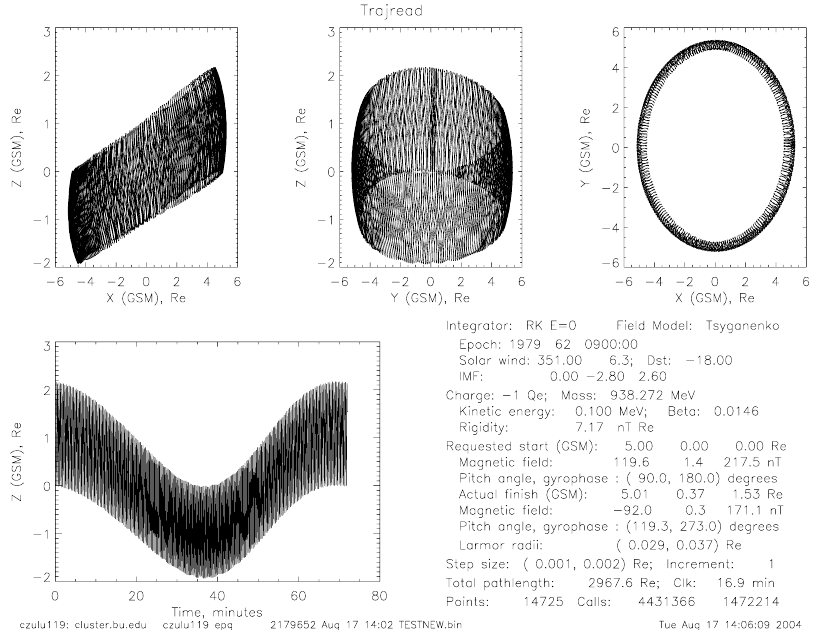
Fig. 11. Example of TRAJGEN code proton trace-back. The trajectory of the particle is plotted in the GSM (a) X-Z (b) Y-Z (c) X-Y planes as well as (d) Z vs. time. The text box provides information about the run.